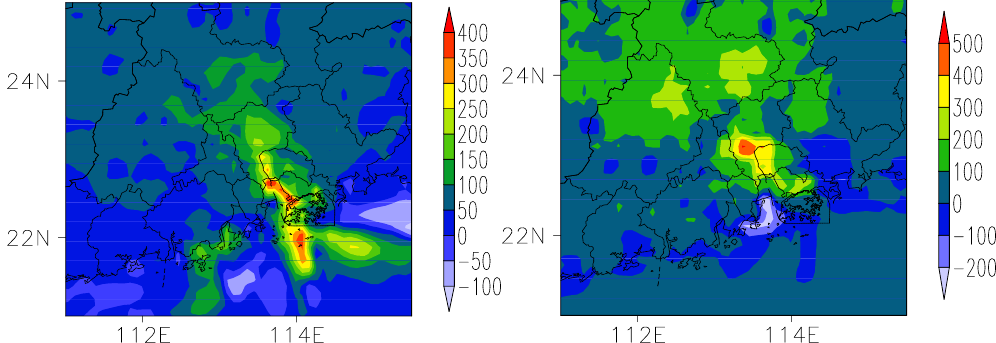
Figure 6. Difference of PAN concentrations between 800 m and surface ( left panel, PAN at 800m − PAN at surface ) and difference of gas-phase chemistry between 800 m and surface ( right panel, CHEM at 800m − CHEM at surface ).